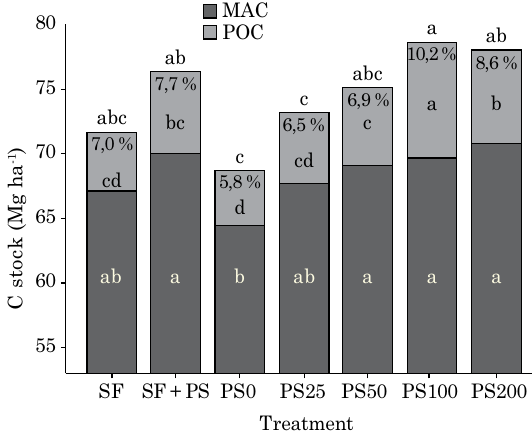
Figure 2. C stocks in the particulate (POC) and mineral-associated fraction (MaC) in the 0-20 cm layer. letters compare the treatments soluble fertilizer (sF), sF + pig slurry (Ps) and Ps by tukey’s mean test (p<0.05). Percentages represent the ratio (POC/tOC×100). sF: treatment with soluble fertilizer as recommended by the Commission of Chemistry and soil Fertility of rs/sC (CQFs-rs/sC, 2004); Ps + sF: treatment with 25 m 3 ha -1 yr -1 , Ps combined with soluble fertilizer to complete the amount of nPk recommended by CQFs-rs/sC; Ps0: unfertilized treatment; Ps25, Ps50, Ps100 and Ps200: treatment with 25, 50, 100 and 200 m 3 ha -1 yr -1 pig slurry,